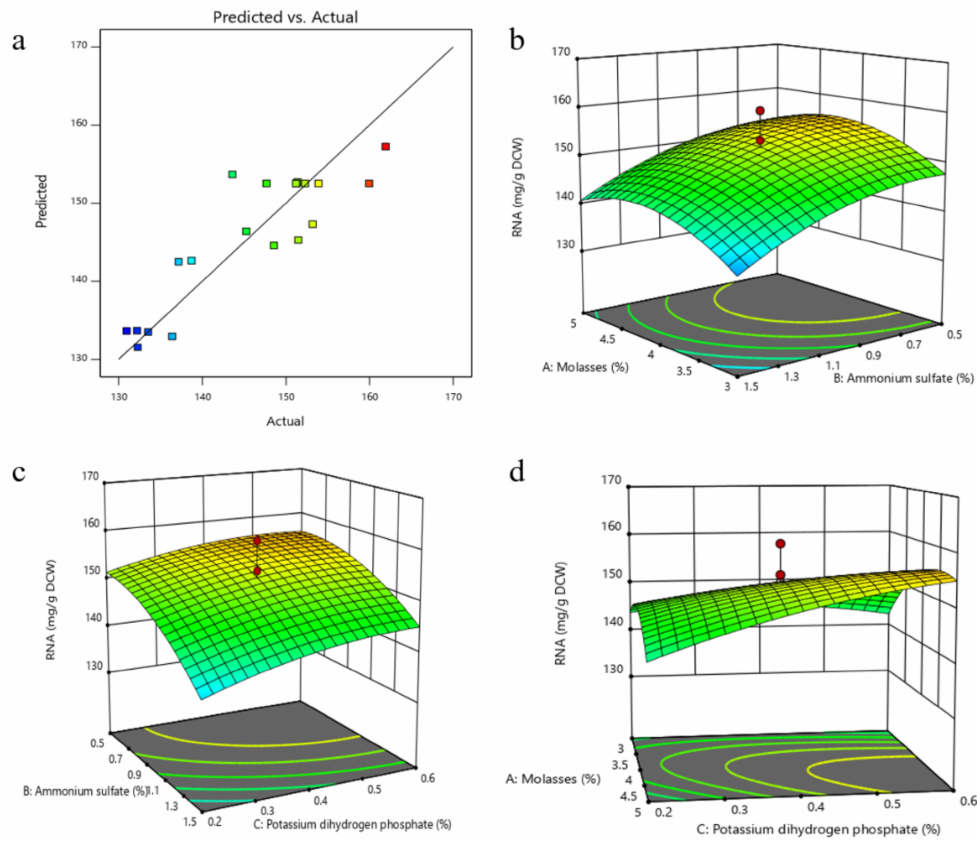
Figure 5. The result of response surface design ( a ), The relationship between the predicted value and the experimental value (Different colors reflected different ranges of RNA content, with blue to red getting higher); ( b ), Response surface curve as a function of molasses and (NH 4 ) 2 SO 4 con- centrations when the KH 2 PO 4 concentration was kept at 0.4%; ( c ), Response surface curve as a function of KH 2 PO 4 and (NH 4 ) 2 SO 4 concentrations when the concentration of molasses was kept at 4%; ( d ), Response surface curve as a function of KH 2 PO 4 and molasses concentrations when the (NH 4 ) 2 SO 4 concentration was kept at